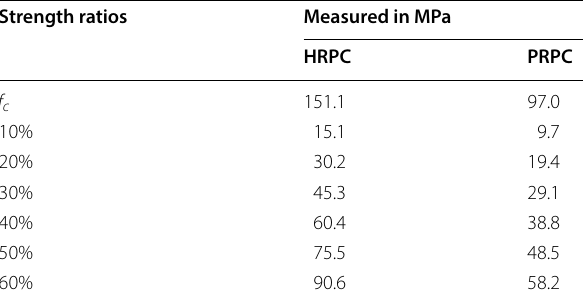
Table 5 Strength ratios for TS testing.